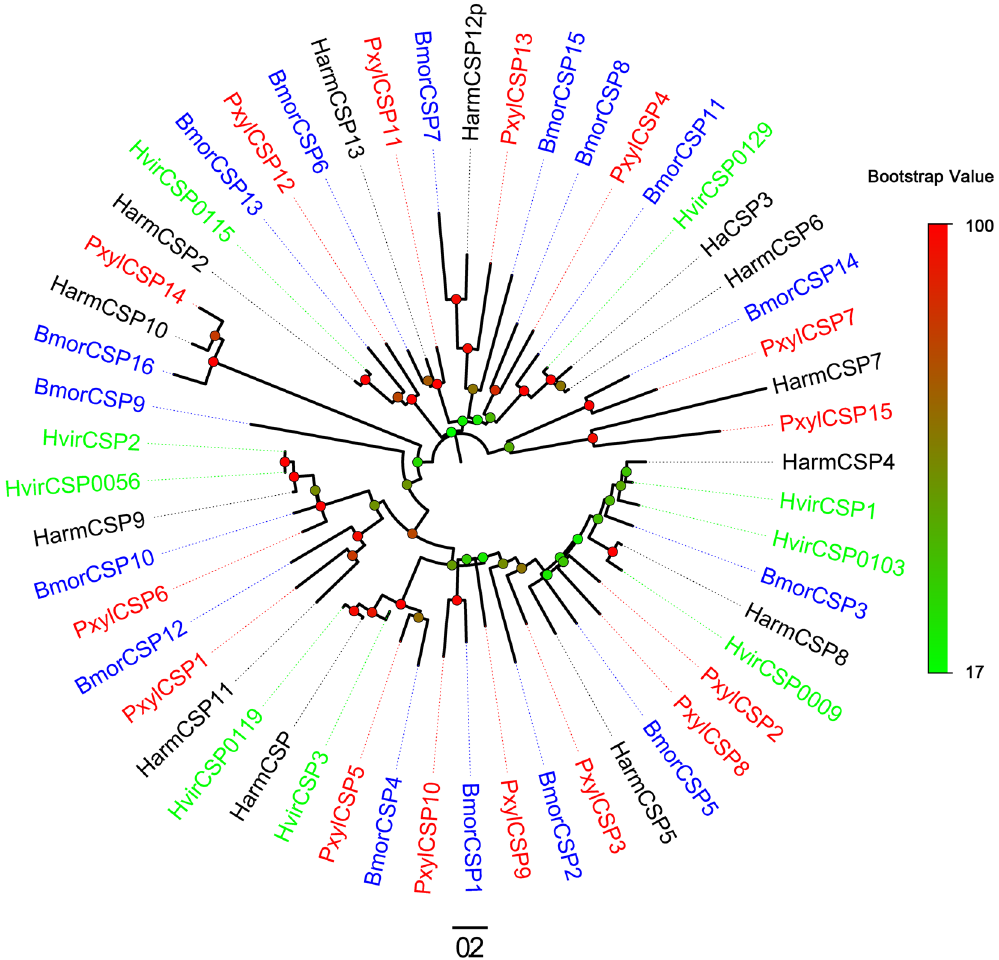
Figure 4. Phylogenetic tree of candidate Lepidopteran CSPs. Pxyl: Pluttela xylostella (red), Harm: Heliocoverpa armigera (black), Hvir: Hethiothis virescens (green), Bmor: Bombyx mori (blue). The bootstrap value for phylogenetic tree construction is 1000.